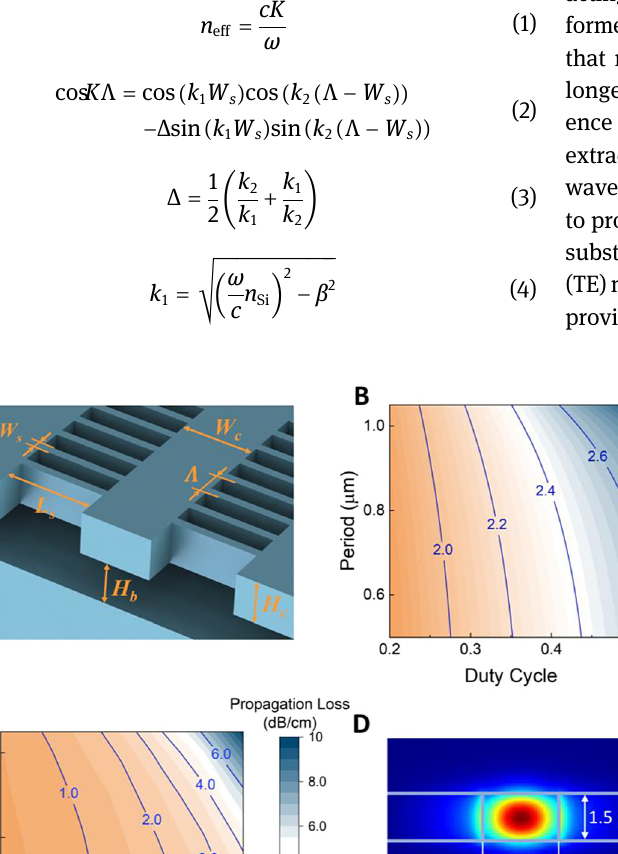
Figure 2: (A) Schematic representation of the suspended waveguide with subwavelength grating (SWG) claddings. (B) SWG equivalent RI n eff and (C) propagation loss of the fundamental quasi transverse electric (TE) mode as a function of SWG period Λ and duty cycle. Waveguide core width and thickness are fi xedtobe2.5and1.5µm,respectively.(D) The fi eld distribution of | E y | for the fundamental quasi-TE mode with the selected SWG period = 1 µm and duty cycle =